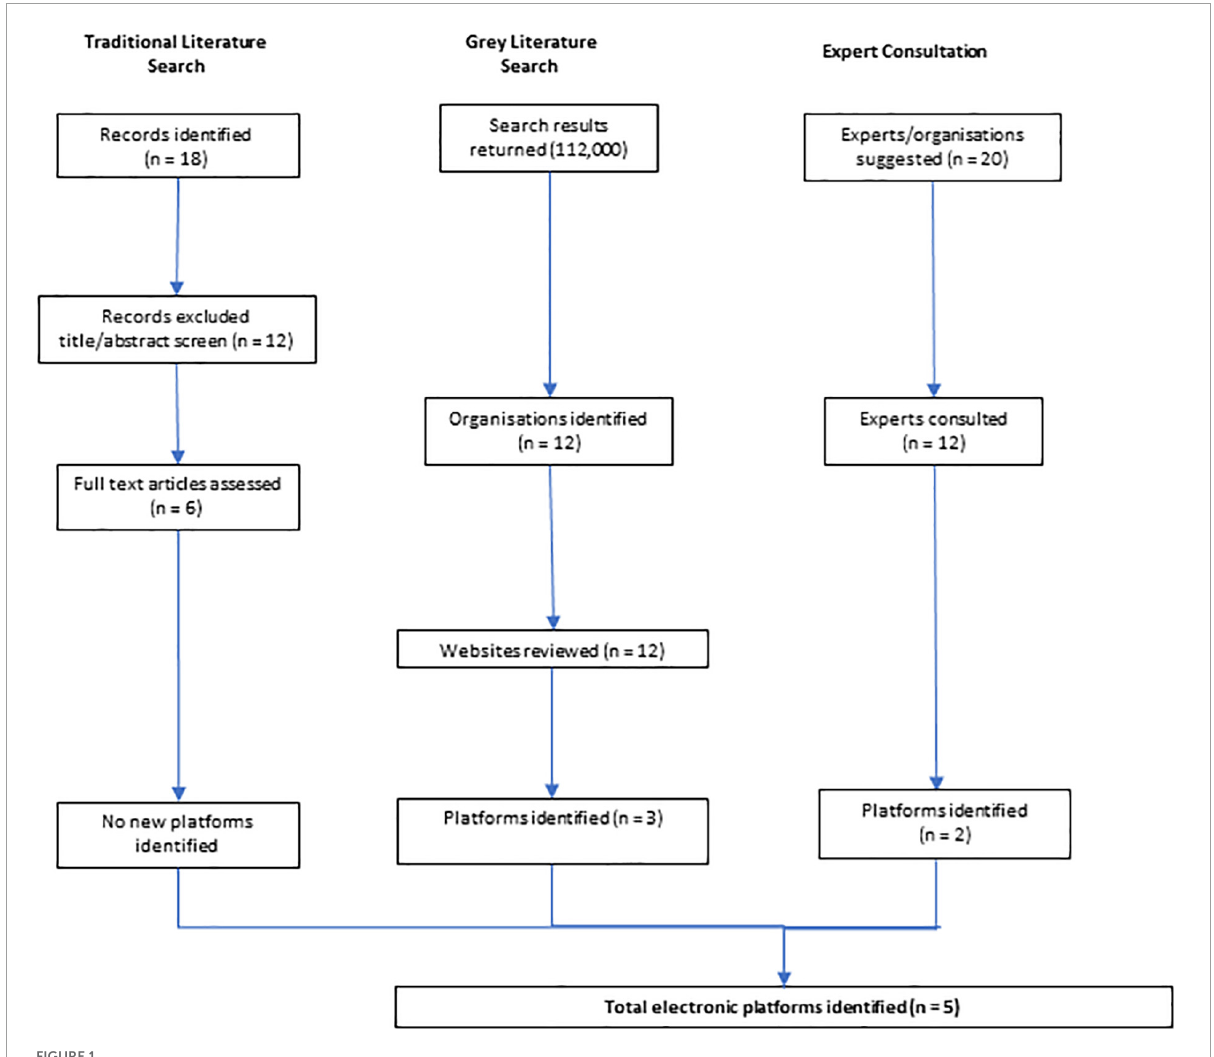
FIGURE1 Flow chart of search